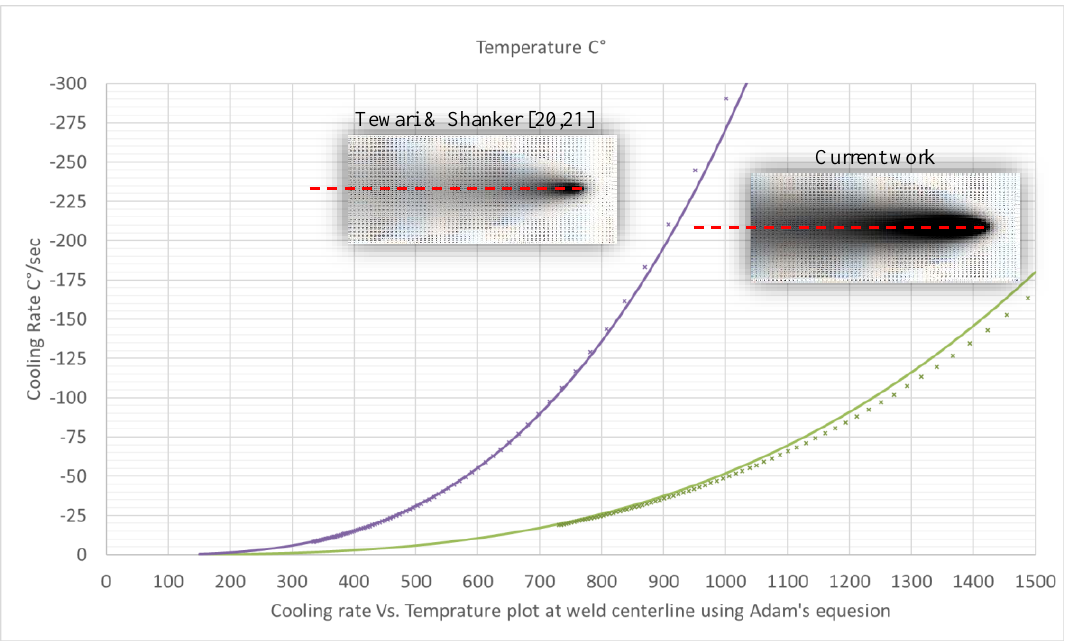
Figure 15. Cooling rates along the fusion zone centerline as a function of momentary temperature. Solid lines are solutions of the Adam’s equation. Symbols are numeric results from Rosenthal’s solution for a temperature distribution ( ∆ T / ∆ t ). The weld in Reference [20,21] had steeper temperature gradients and higher cooling rates than those in the current work.